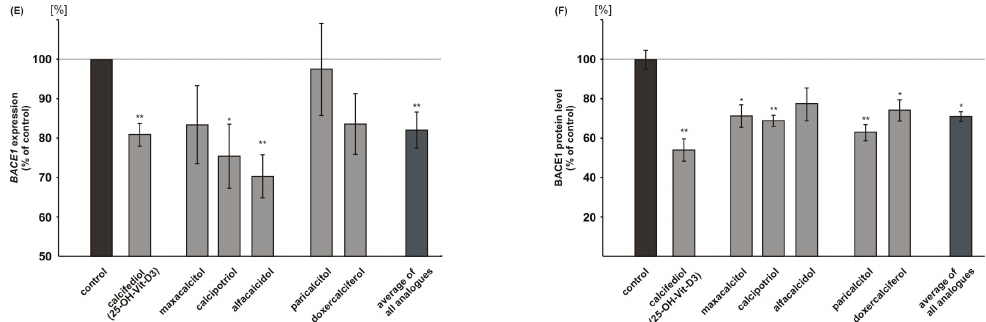
Figure 2. Effect of vitamin D and analogues on A β generation. Cells were treated with 25(OH) vitamin D 3 (calcifediol), the vitamin D 3 analogues maxacalcitol, calcipotriol, alfacalcidol, the vitamin D 2 analogues paricalcitol, doxercalciferol in a final concentration of 100 nM or solvent control (EtOH). ( A ) Total secreted A β level in SH-SY5Y APP695 overexpressing cells ( n = 3). A β of the conditioned media was analyzed by immunoprecipitation and Western Blot (WB) analysis. Using Post Hoc analysis, no significant differences between calcifediol and analogues were found in respect to their potential to reduce A β level. ( B ) Determination of α -secretase activity in living SH-SY5Y wt cells ( n = 7). ( C ) Analysis of β -secretase activity in isolated membranes of SH-SY5Y wt cells ( n = 7) and in living cells ( n = 5). ( D ) β -secretase activity in three wt mouse brain and five vitamin D deficient mouse brain homogenates ( n = 3). Vitamin D and analogues influence β -secretase activity in wt mouse brains and in vitamin D deficient mouse brains. ( E ) RT-PCR analysis of BACE1 in SH-SY5Y wt cells ( n = 3). ( F ) Determination of BACE1 protein level in cell lysates of SH-SY5Y wt cells by WB analysis ( n = 3). Control conditions were set to 100% and illustrated as a line in the graphic. Error bars represent the standard error of the mean. Asteriks show the statistical significance calculated by unpaired